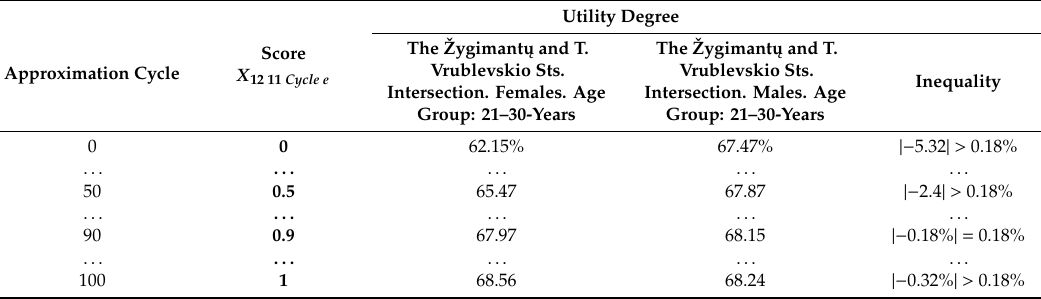
The bold is used for calculations and result explanations.